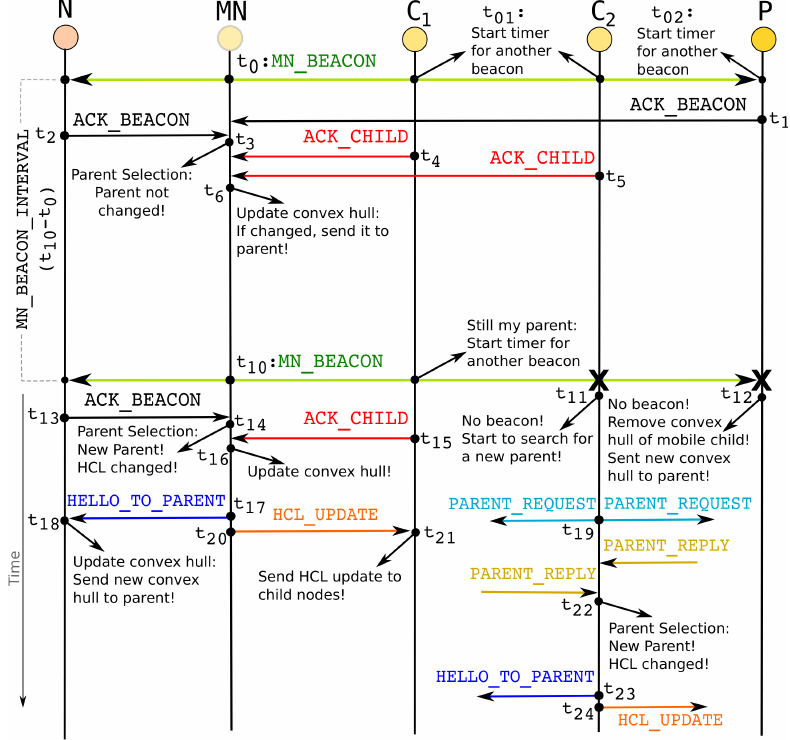
Figure 5. Messaging during local